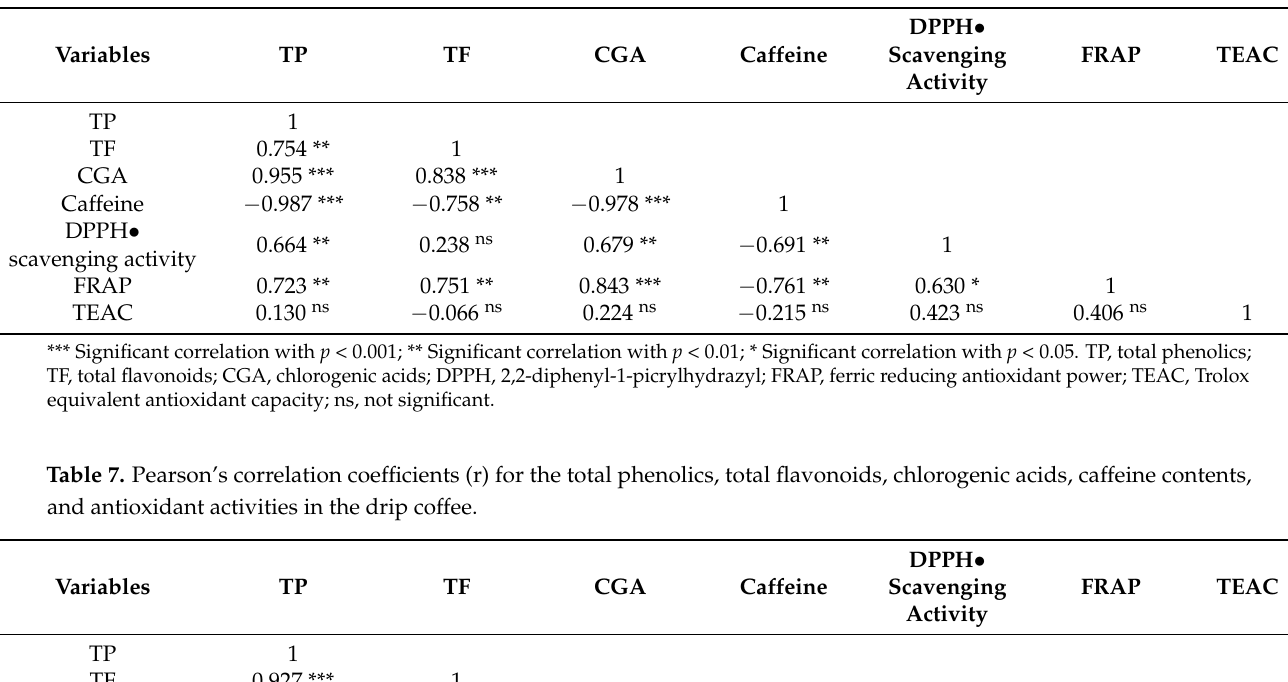
Table 6. Pearson’s correlation coefficients (r) for the total phenolics, total flavonoids, chlorogenic acids, caffeine contents, and antioxidant activities in the espresso coffee.